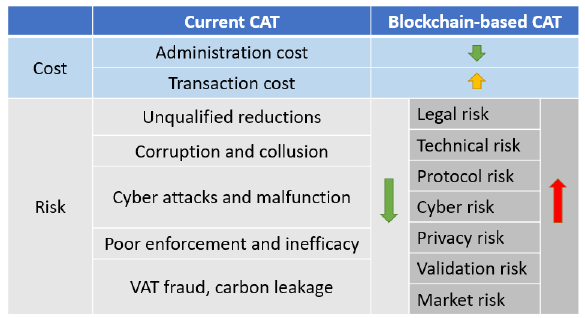
Figure 1. Cost and risk structure of current and blockchain-based